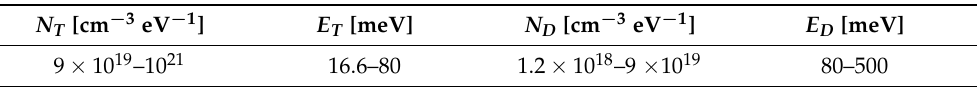
Table 1. Range of parameter values for the acceptor-like states in the polysilicon, according to the lit- erature (see text for